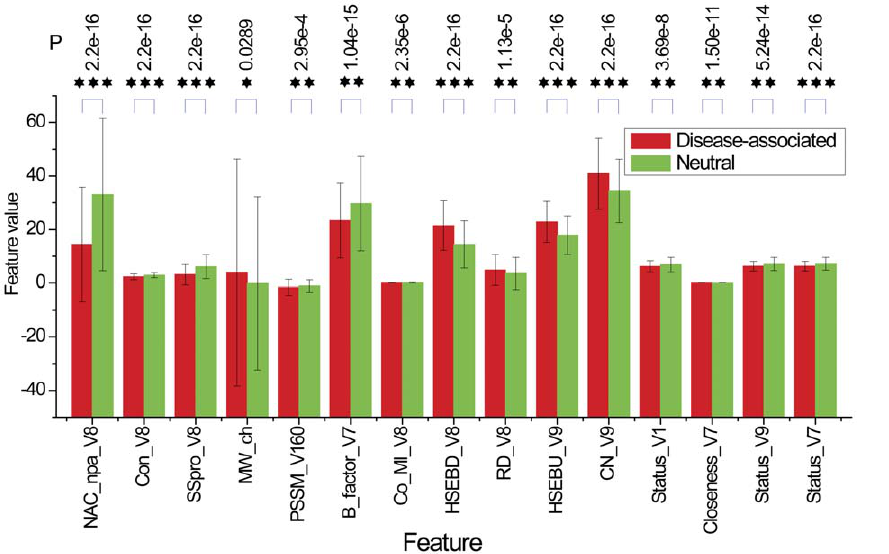
Figure 3. Comparison of the mean values and standard deviations of the 15 optimal features of disease-associated and neutral SAVs. ‘‘*’’ represents a P -value in the range of 0.01 , 0.05, ‘‘**’’ represents a P -value in the range of 2.2e-16 , 0.01, while ‘‘***’’ represents a P - value , 2.2e-16, respectively. See Table 2 for more details about feature abbreviations.